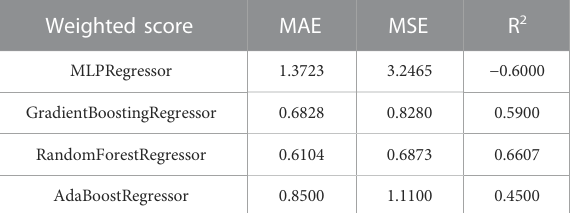
TABLE 4 Evaluation data of the dual feature screening combination optimisation method. Weighted